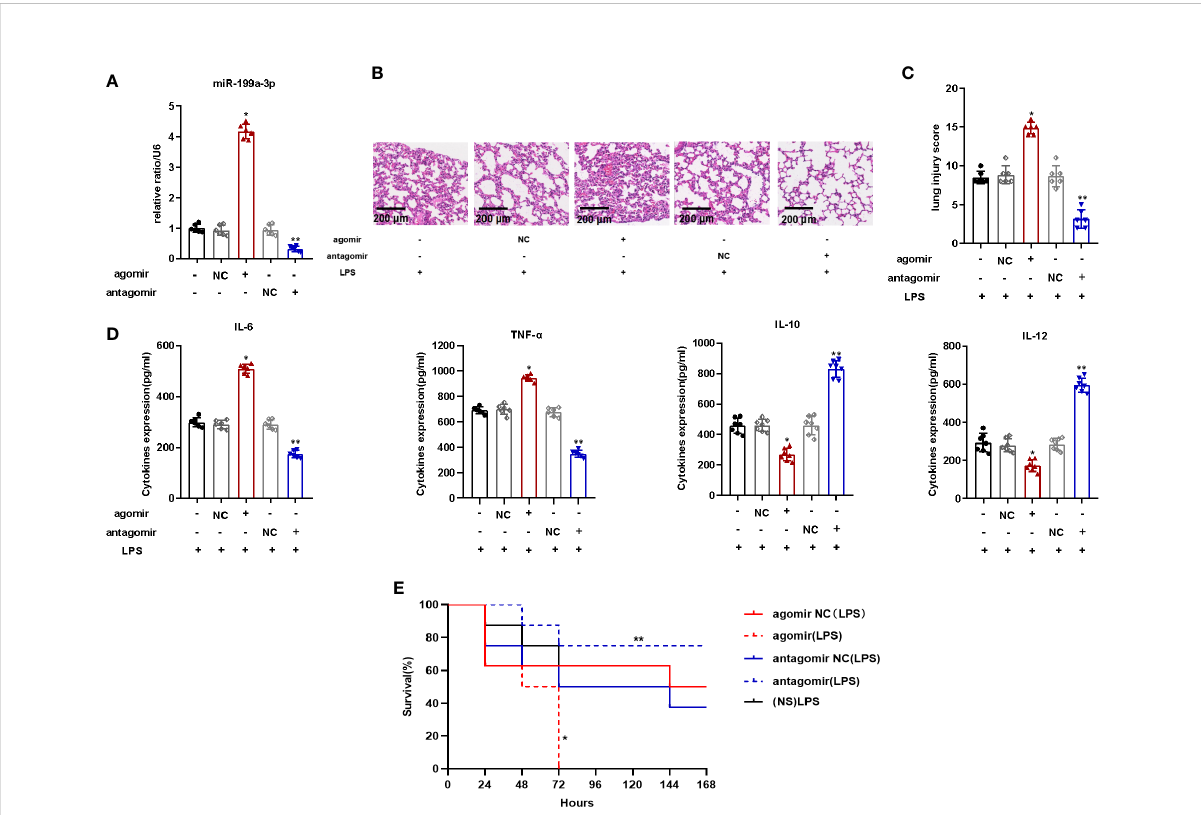
FIGURE 2 MiR-199a-3p over-expression exacerbated LPS-induced ARDS in mice. The agomir of MiR-199a-3p, agomir NC, antagomir of MiR-199a-3p, and antagomir NC were injected into mice via the tail vein. (A) MiR-199a-3p expression in lung tissue from mice in each group was detected by qRT-PCR (n=6 per group). (B) Histopathological images of lung samples (haematoxylin and eosin staining; scale bar = 200 µm). (C) Injury scores of the lung samples (n=6 per group). (D) In fl ammatory cytokine levels in the lungs of mice from different groups were assessed using ELISA (n=6 per group). (E) Kaplan-Meier survival curves were used to demonstrate the effect of MiR-199a-3p on murine survival (n=7 per group). The experiments were repeated at least three times. Each value represents the mean ± SD of three independent experiments. *p < 0.05 vs . the agomir NC group, **p < 0.05 vs . the antagomir NC group, one-way ANOVA or log-rank